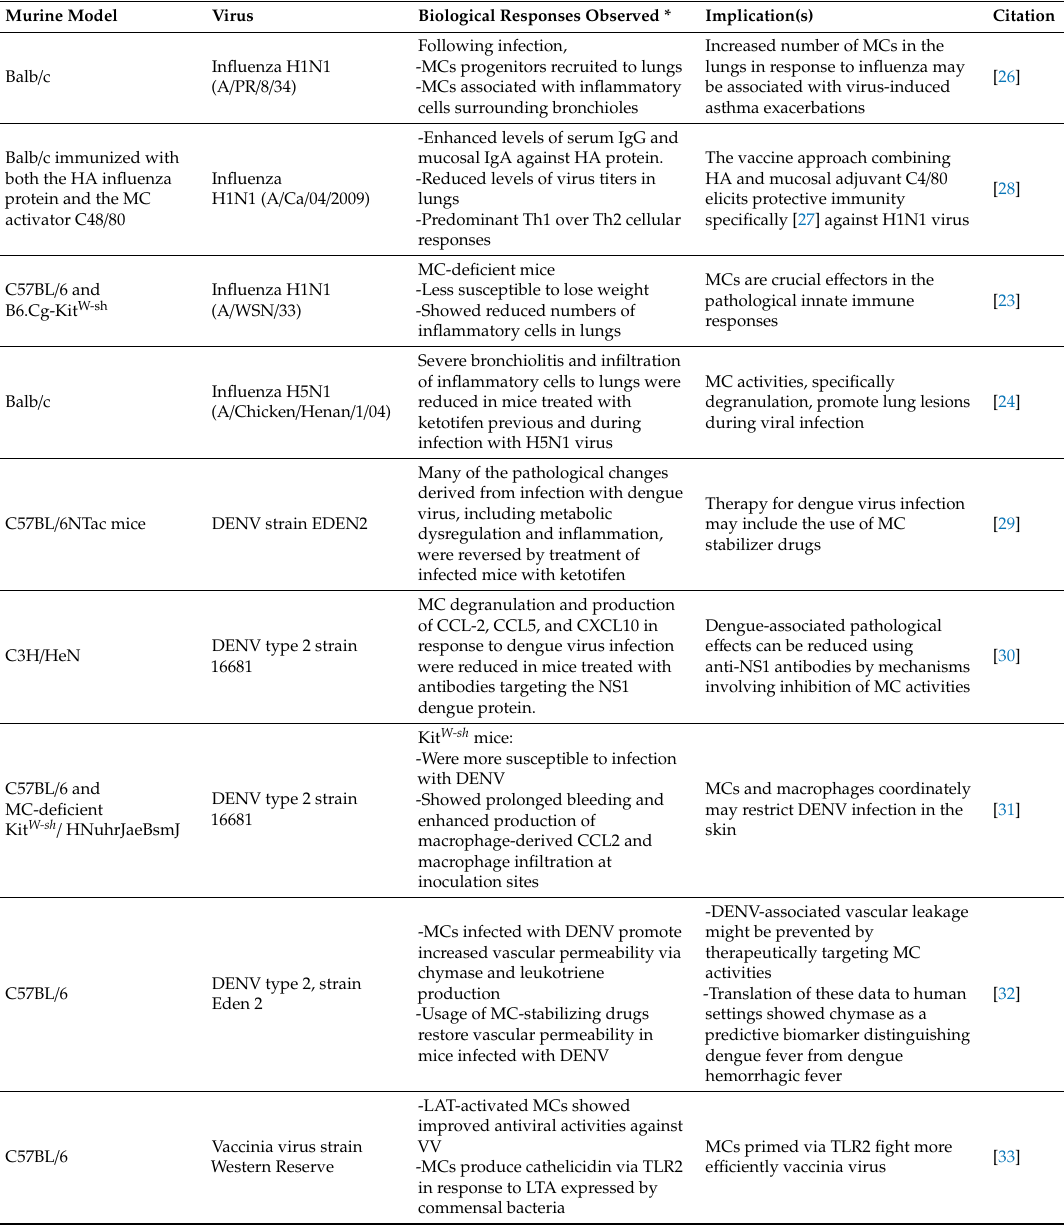
Table 2. Key murine studies of MCs in viral